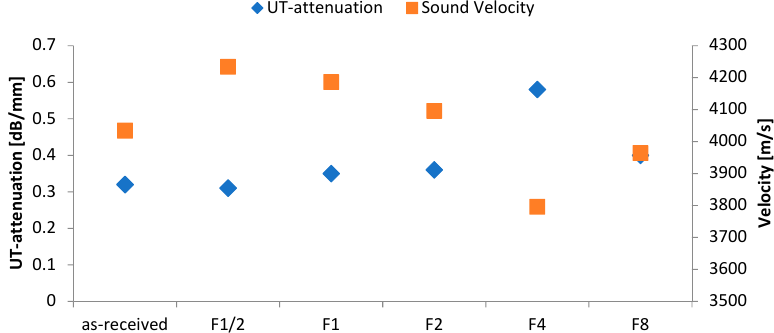
Figure 5. Ultrasonic test (UT)-attenuation results for different annealing socking times.